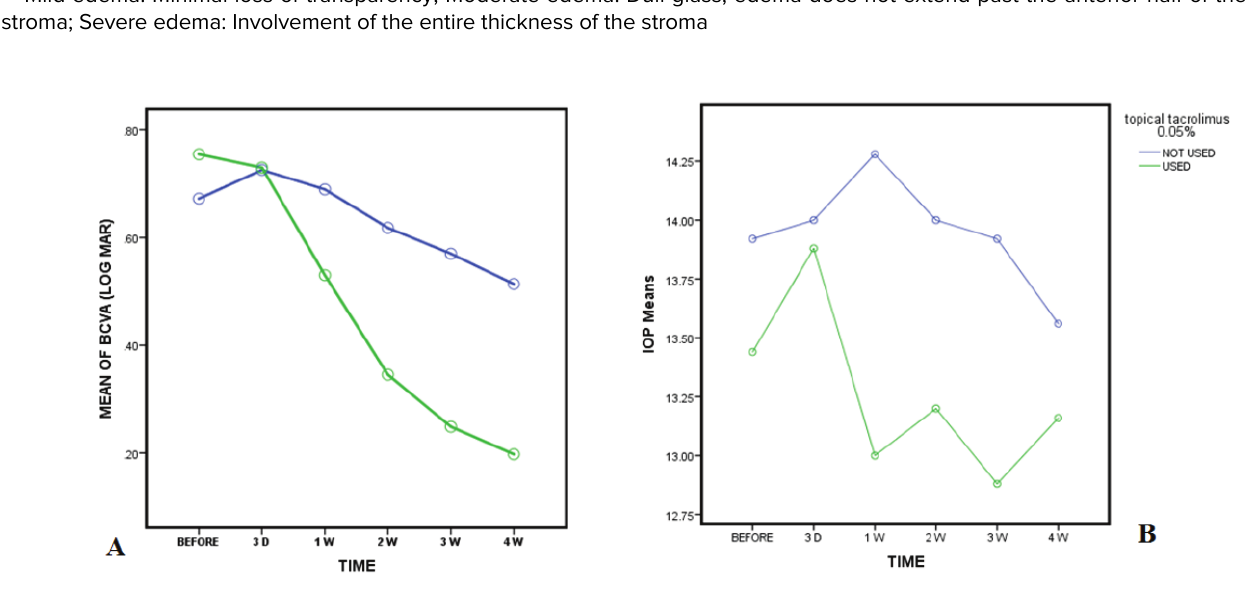
Figure 1. The trend of mean LogMAR of best corrected visual acuity (BCVA) (A) and intraocular pressure (IOP) (B) at baseline, 3 days, 1, 2, 3, and 4 weeks after the intervention in the case (used tacrolimus) and the control (tacrolimus was not used)